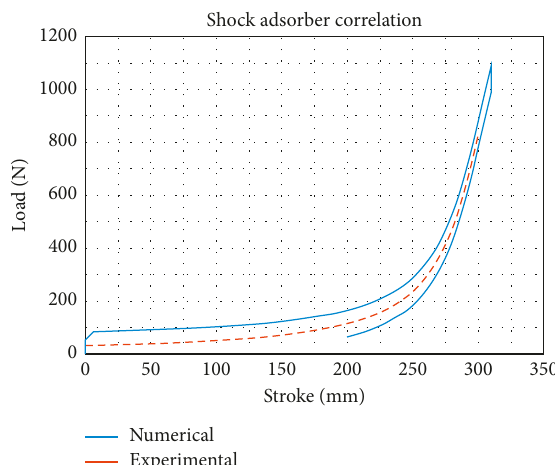
Figure 21: Force vs. shock absorber stroke curve.